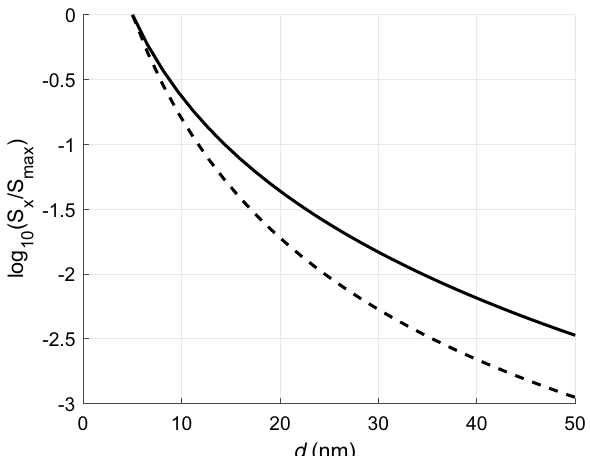
13 15 , T 307 K, τ 10 τ 1 τ 2 s (solid curve), and − = = = = =